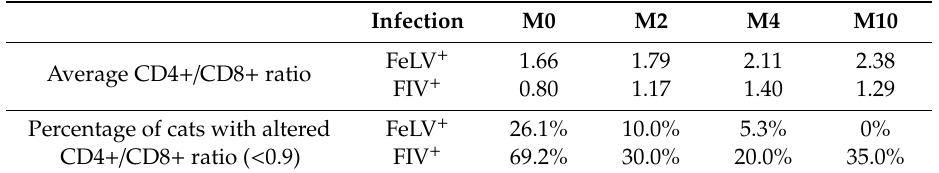
Table 4. Average value of the CD4 +/ CD8 + ratio (normal value ≥ 0.9), and percentage of cats treated with rHuIFN- α with subnormal